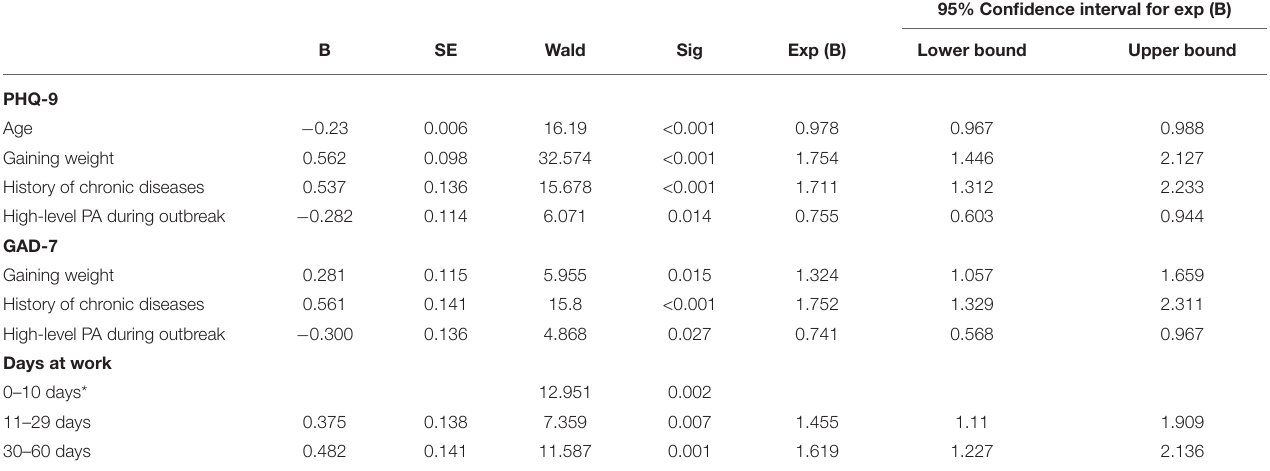
TABLE 4 | Regression results for the PHQ-9 and GAD-7